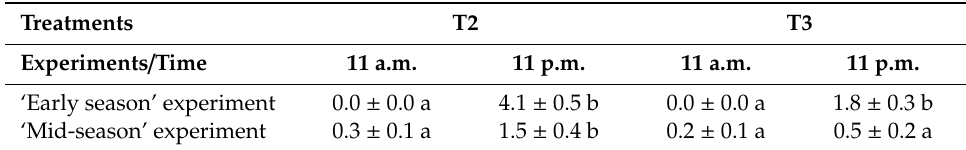
Table 5. Mean number ( ± SE) of Gamasina mites per plant at 11 a.m. and 11 p.m. ( n = 6 plants) with straw mulching: ‘Early season’ (oat straw: T2, since 2018; T3, since 2017); ‘Mid-season’ (barley straw: T2, since 2018; T3, lower layer since 2017 and top layer since